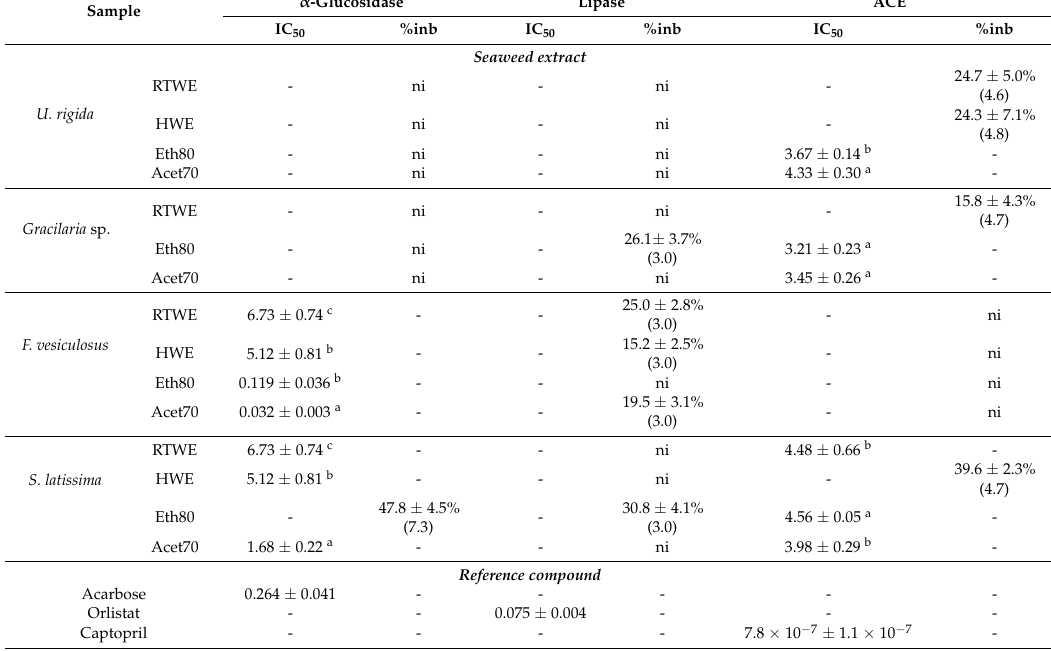
Values of inhibition of seaweed extracts are expressed as IC 50 (in cases where at least 50% of inhibition was achieved for the maximum tested concentrations) or as % of inhibition (in cases where 50% of inhibition was not achieved for the maximum tested concentration). IC 50 values of seaweed extracts and reference compounds are expressed as mg/mL. %inb—% inhibition of extract, expressed in %, observed for the maximum tested concentration (value in parenthesis); “-“—not determined; ni—no inhibition. HWE of Gracilaria sp. was not obtained due to its high agar content which limits processing. Different letters in the same column (for each seaweed) indicate significant differences ( p <